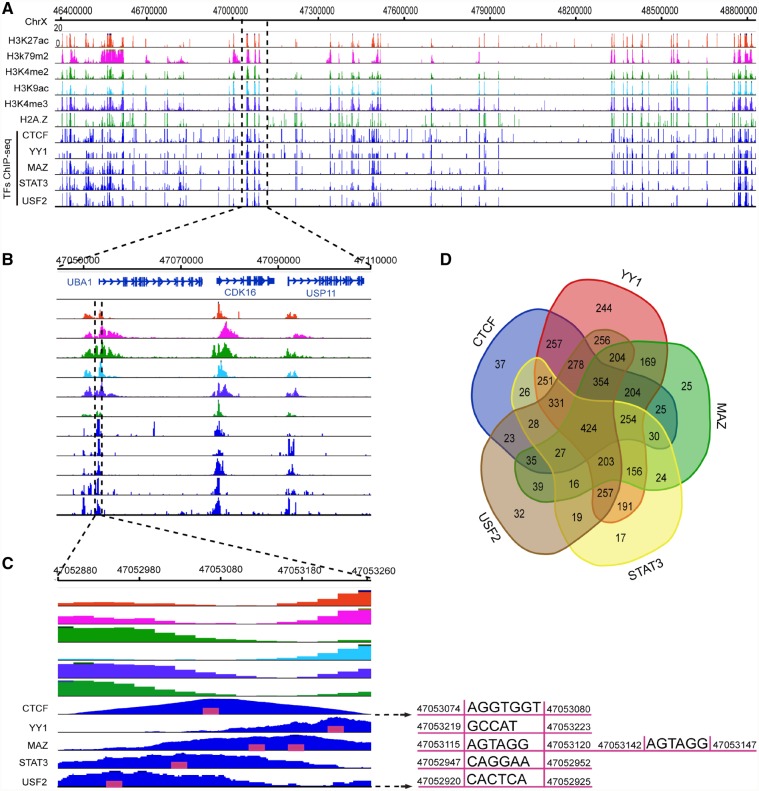
Integrative analysis of CTCF and combinatorial TFs on chrX. (A) The co-localizations of TF-binding peaks and histone modifications on a ∼2.4 Mb region of chrX. (B) A zoom-in region of three genes. (C) A zoom-in region shows the complementary signals of TF-binding peaks and histone modifications. The right side shows the DNA motifs and their coordinates of five TFs. (D) Venn graph shows the genomic overlapping of five TFs among CTCF-binding peaks.